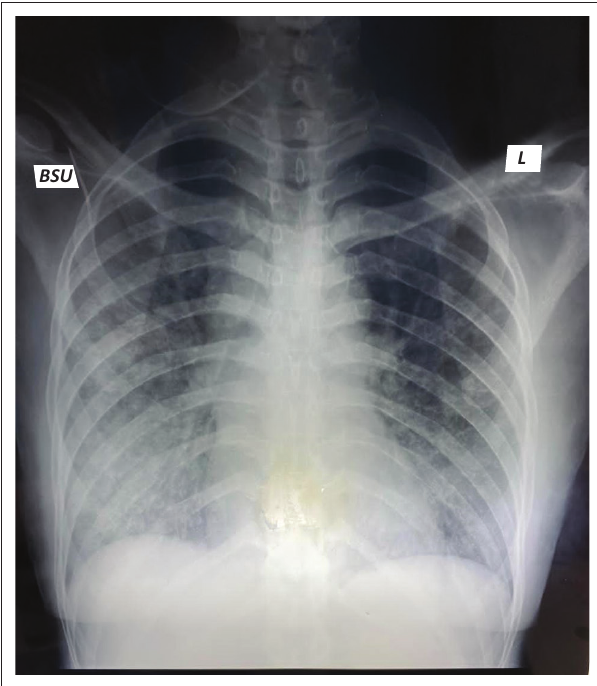
FIGURE 1: Chest radiograph (postero-anterior